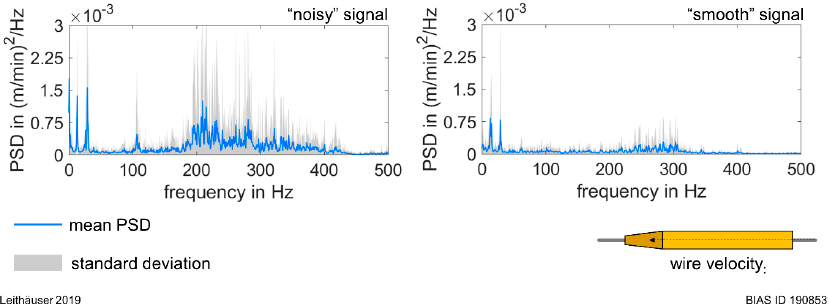
Figure 8. Mean PSD and standard deviation of the wire velocity, including all samples with ( left ) and without ( right ) dominant frequencies between 160 and 400 Hz. without ( right ) dominant frequencies between 160 and 400